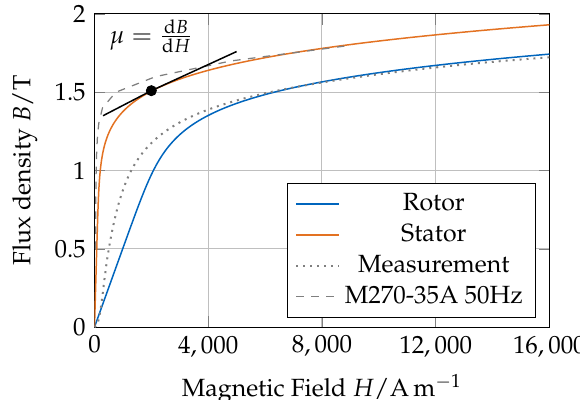
Figure 3. Generic material laws for the rotor and stator in comparison to data from the